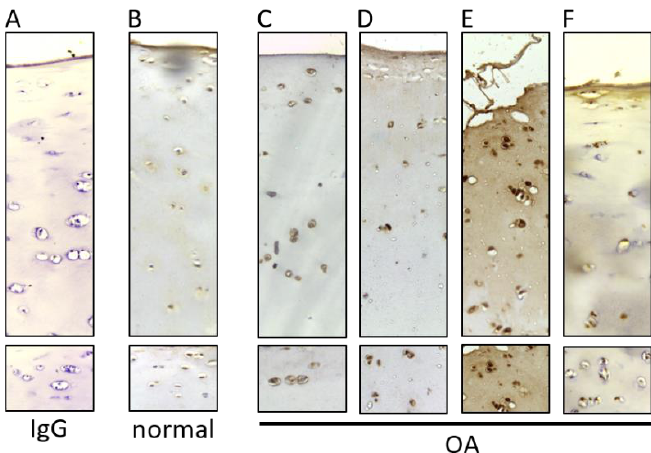
Figure 1. Protein detection of LSD1 in normal and osteoarthritis (OA) cartilage. Tissue sections of human cartilage obtained from non-diseased cartilage ( B ), or OA cartilage from several donors were immunostained for LSD1 ( C – F ). IgG was used as a control where the primary antibody was omitted ( A ) or not ( B ) and using OA cartilage.